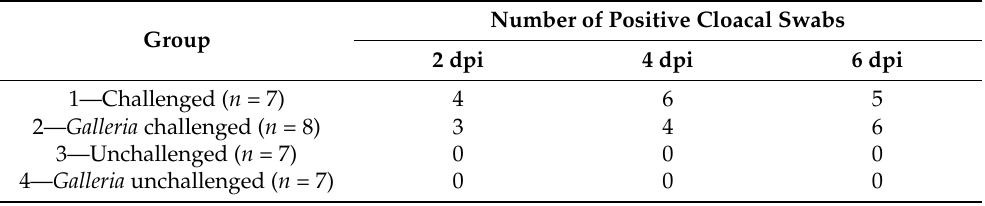
Table 1. Total number of broiler chickens shedding C. jejuni M1, tested by collection of cloacal swabs at 2, 4 and 6 days post-challenge.